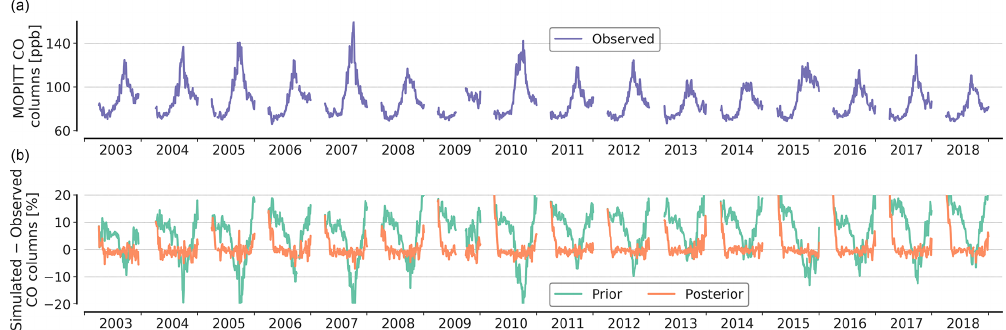
Figure 5. A comparison between simulated and MOPITT-retrieved CO columns for the GFAS reference inversion. Panel (a) shows the TM5-simulated and MOPITT-retrieved CO columns, averaged over the inner 1 ◦ × 1 ◦ zoom domain and at a 3d time resolution. Note that the posterior simulation and the MOPITT-retrieved CO columns largely overlap; thus, the latter is poorly visible. Panel (b) presents the relative difference between satellite-retrieved and simulated MOPITT CO columns, in a simulation with the prior GFAS emissions (green) and after the MOPITT CO column retrievals have been assimilated to optimize fire emissions (orange), averaged as in panel (a) . The difference between the simulated and observed columns is quantified as a percentage of the average satellite-retrieved CO